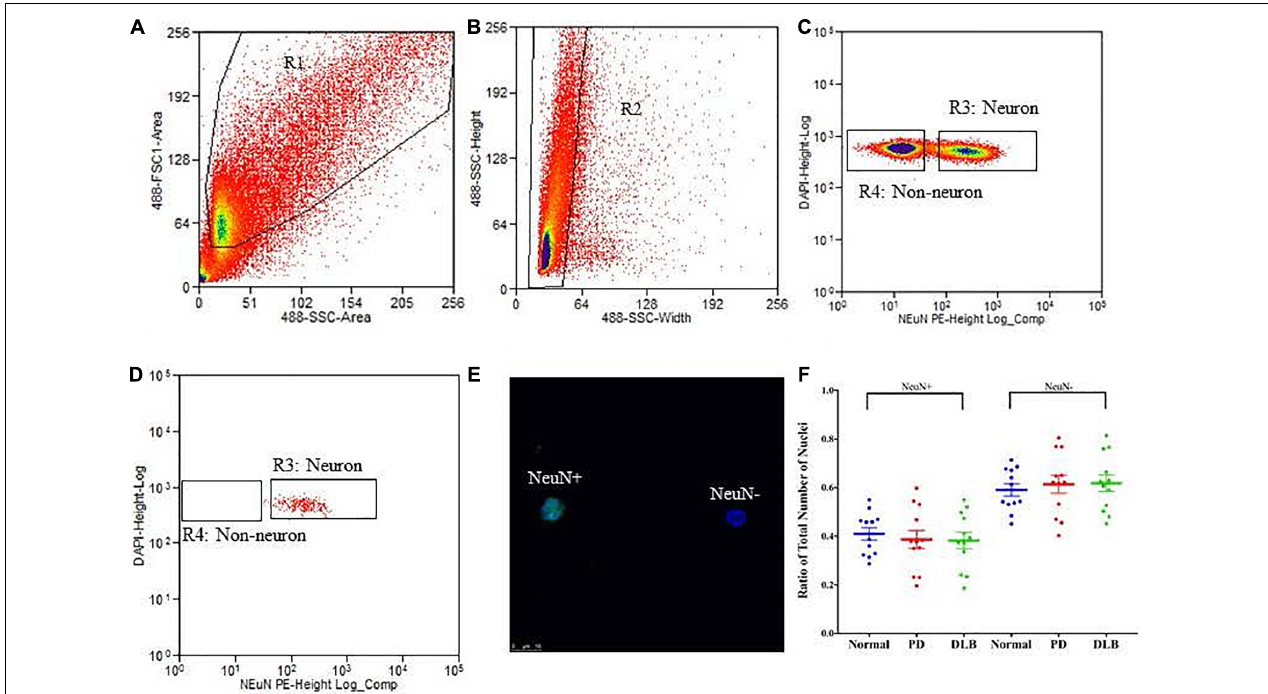
FIGURE 3 | Isolation of nuclei from frozen brain samples. Human postmortem frontal cortex was dissociated; nuclei were isolated and stained with the nuclear stain DAPI and a monoclonal NeuN antibody conjugated to PE. The panels represent an example of a single sort experiment performed using a particular brain donor (subject ID 1690). (A) Nuclei were first sorted based on their forward and side scatter from all possible events (R1 gate). (B) Single nuclei were further sorted based on their size from the doublets or larger clumps of nuclei (R2 gate). (C) DAPI positive single cells were gated as either NeuN-PE positive (neurons, R3 gate) or NeuN-PE negative (glia, R4 gate). (D) Post-sort data showing the purity ( > 97%) of the separation between neuronal and non-neuronal nuclei. (E) Fluorescence image showing unsorted nuclei stained for NeuN (green) and DAPI (blue). The scale bar represents 10 µ m. (F) Box-and-scatterplot chart of the ratios of neuronal (NeuN+) and non-neuronal nuclei (NeuN-) from total nuclei for each neuropathological group. Each point represents the ratio for an individual sample. The box denoted the mean (thick horizontal line) and upper and lower quartiles (thin shorter